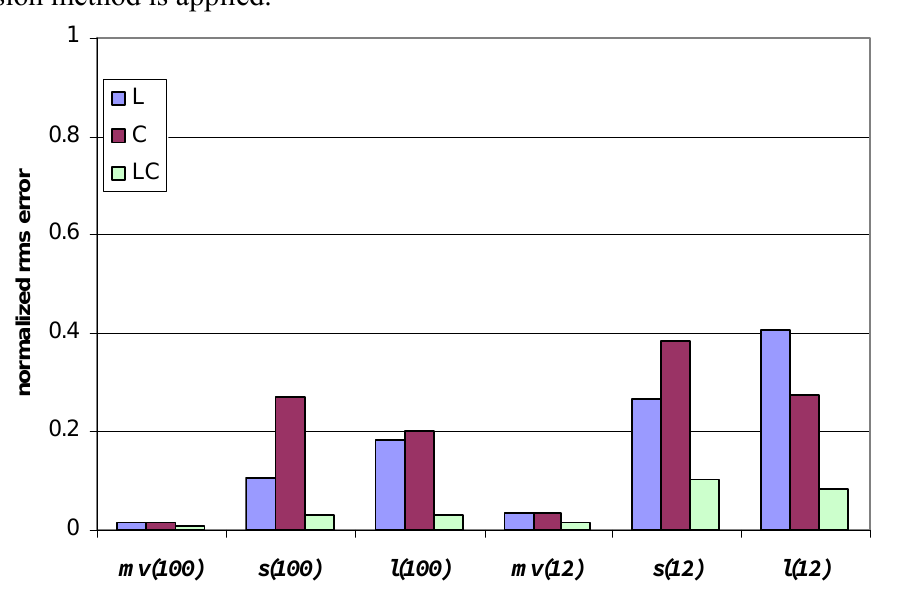
Figure 3 . Accuracy estimation (in terms of normalized rms error) vs. frequencies and number of looks (reported between brackets) for IEM simulated measurements at ψ =20°. NN inversion method is applied.